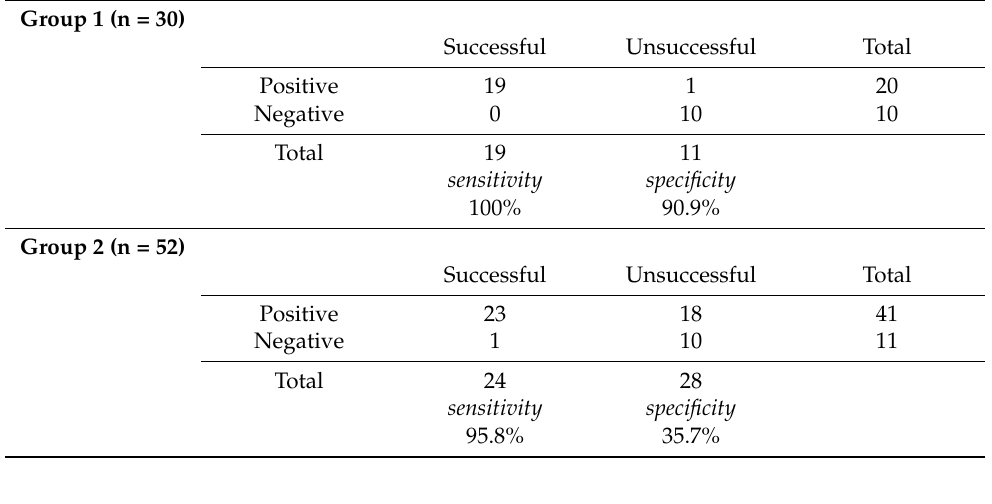
Table 1. Frequency Distribution of Discriminant Scores in Successful and Unsuccessful Returns.